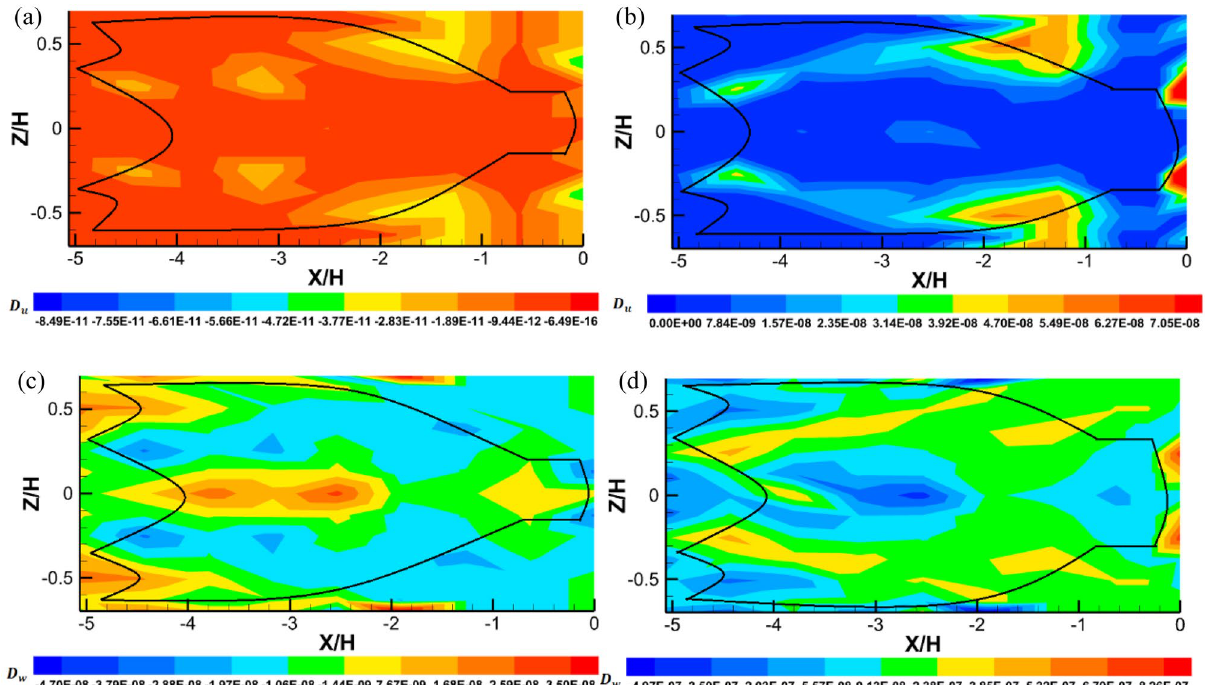
Figure 9. Turbulent flux components of the flow field inside and around midwater trawl net Trawl without catch ( a and c ) and Trawl with catch ( b and d ).